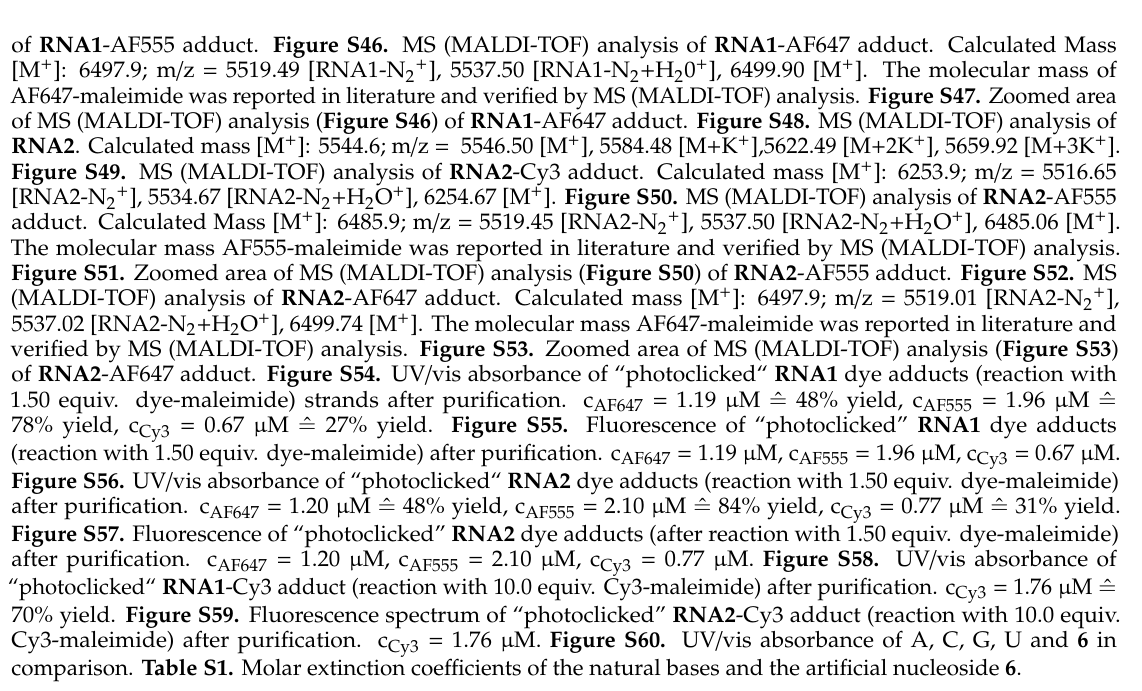
Figure S49. MS (MALDI-TOF) analysis of RNA2 -Cy3 adduct. Calculated mass [M + ]: 6253.9; m / z = 5516.65